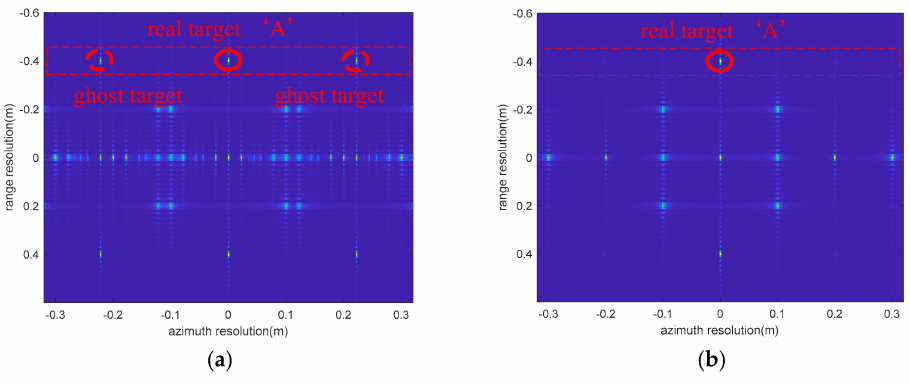
Figure 12. Imaging results without ( a ) and with ( b ) compensation under condition 2.